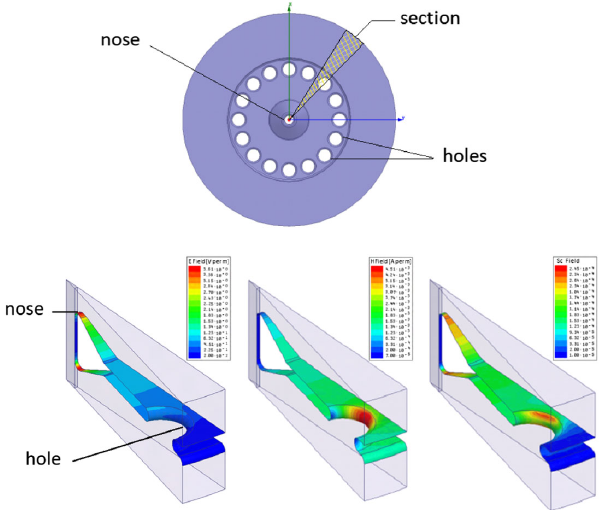
FIG. 1. Regular disk shape (top). Normalized electric field E=E (left), normalized magnetic field H=E a ized modified Poynting vector S section ( 1 = 32 azimuthal symmetry)